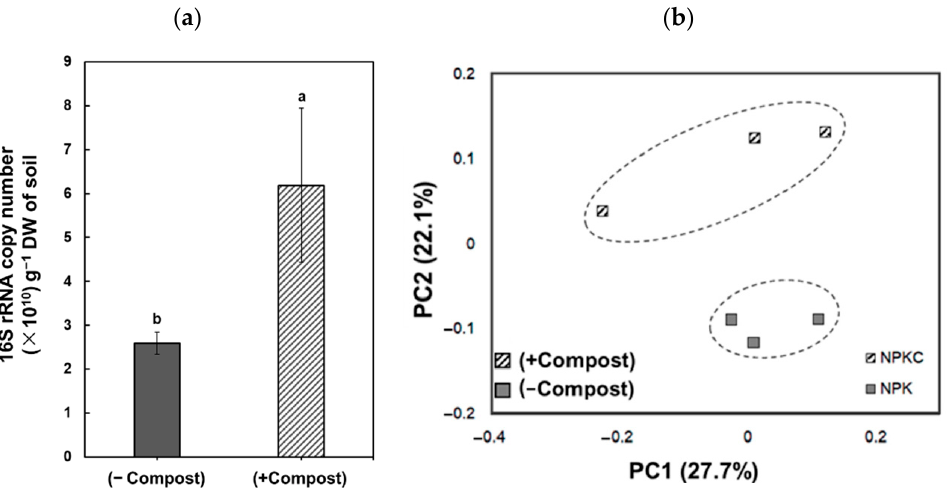
Figure 1. ( a ) The 16S rRNA copy numbers of soil bacterial communities estimated by qPCR. ( b ) The principal coordinate analysis (PCoA) showing the clustering of bacterial communities between soil samples. Values for 16S rRNA data are plotted with mean; error bars indicate standard errors; different letters on plot mean significant difference ( p < 0.05) between treatments according to Tukey’s